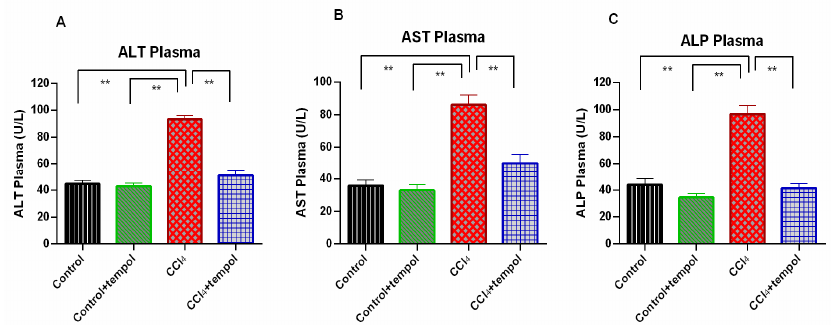
Figure 2. Effect of tempol on ALT, AST and ALP activities in plasma of CCl 4 -administered rats. Every value was represented as mean ± SEM. N = 6. One-way ANOVA followed by Tukey’s test were performed for statistical analysis. For statistical significance, p < 0.05 is considered significant in all cases. Here, ** means p < 0.001.